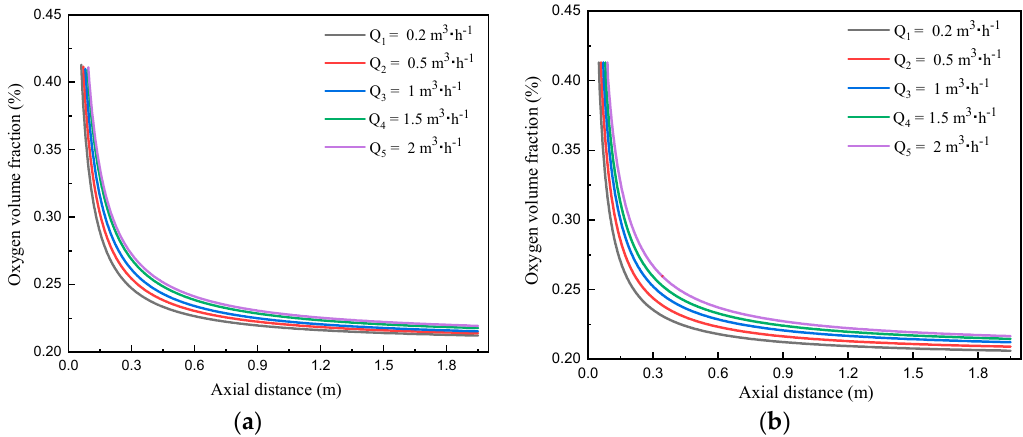
Figure 6. Axial oxygen concentration distribution with a single oxygen supply vent for different oxygen flow rates: ( a ) D 1 = 0.006 m, ( b ) D 2 = 0.01 m.